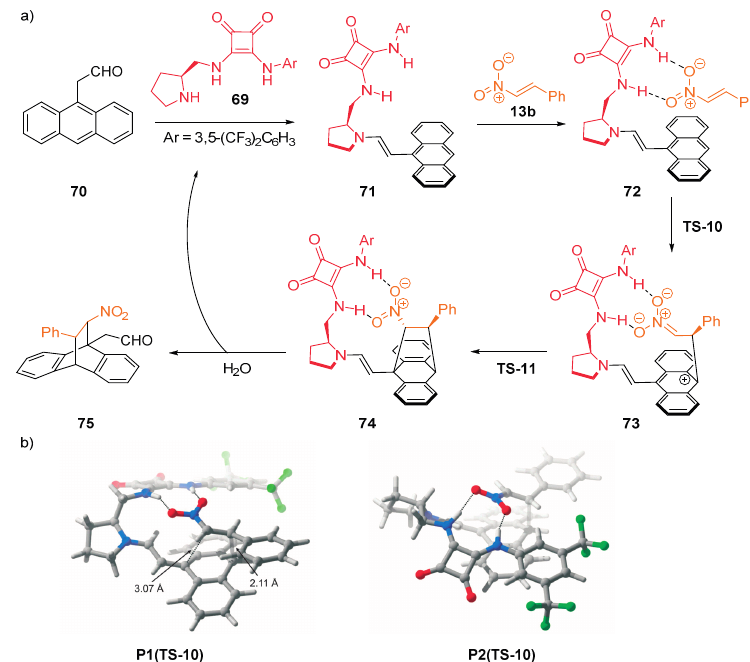
Figure 17. Diels-Alder reaction of anthracene 70 and nitroalkene 13b ( a ); optimized structures of P1(TS-10) and P2(TS-10) ( b ). Adapted with permission from Ref. [50]. Copyright (2013) John Wiley and Sons.